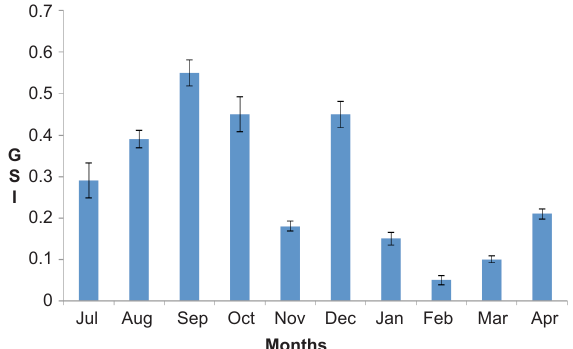
Figure 6. Monthly average of Gonado Somatic Index of male S. gymnopomus